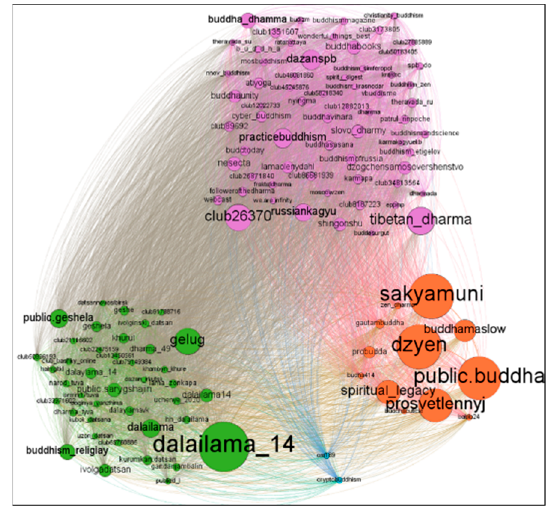
Figure 1. Graph clustering.